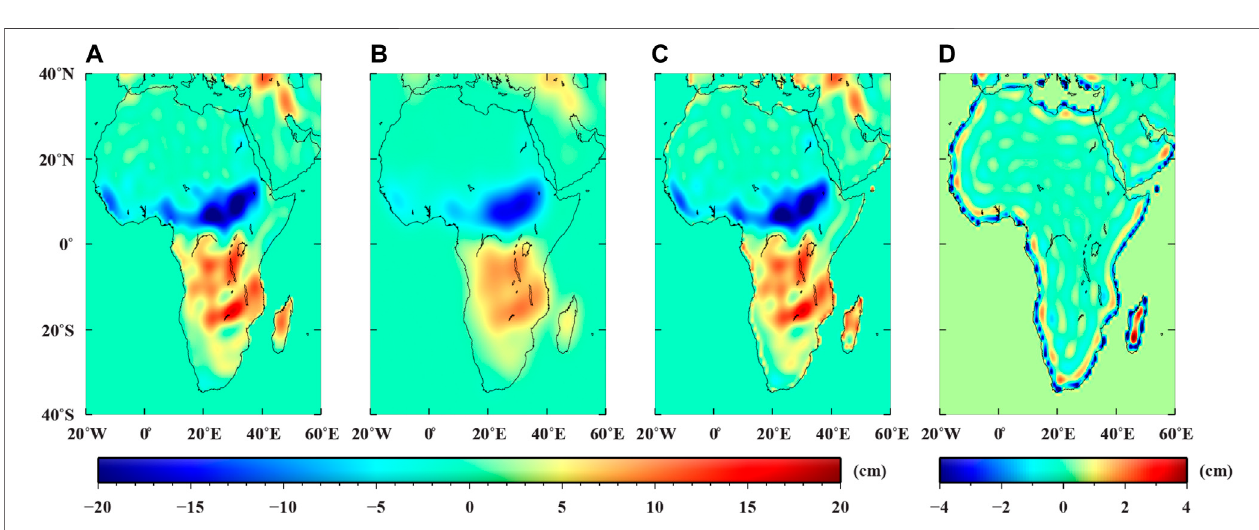
FIGURE 4 | Mass variations in terms of cm equivalent water heights. (A) Original mass variations from ESM HIS model; (B) Mass variations after 500 km Gaussian smoothing; (C) forward-modeling mass variations; (D) differences between original and forward-modeling mass variations, i.e., (a) minus (c). Note the different color scales for the four